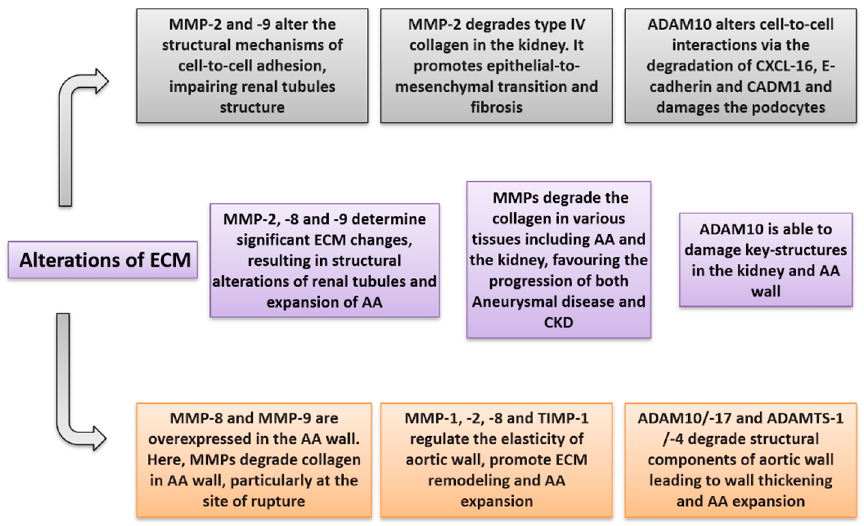
Figure 3. Alterations of extracellular matrix (ECM) caused by metalloproteinases in CKD (grey), aortic aneurysm (orange), and both conditions (violet).